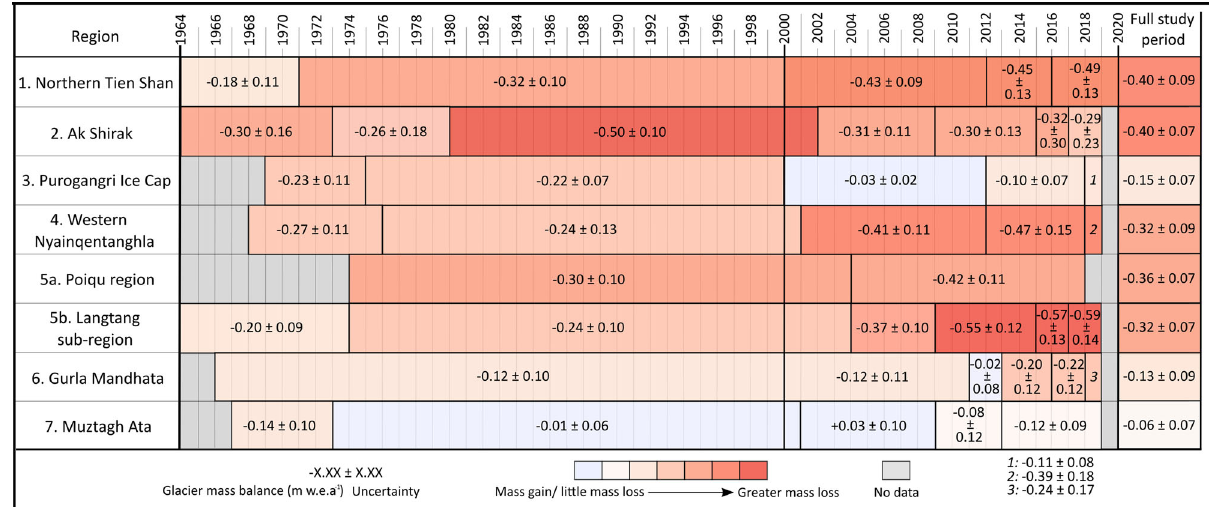
Fig. 2 Summary of the geodetic glacier mass budgets in different time periods for all the studied regions along High Mountain Asia (HMA). Notwithstanding temporal heterogeneity over the entire study period, extensive ice-mass loss has occurred in all the seven study regions. Several regions, such as, Northern Tien Shan, Western Nyainqentanghla and Poiqu/Langtang have experienced consistent increase in mass loss rates throughout the observation periods. In Muztag Ata, where glaciers had lost little mass for several decades, glacier mass loss has occurred in the recent time